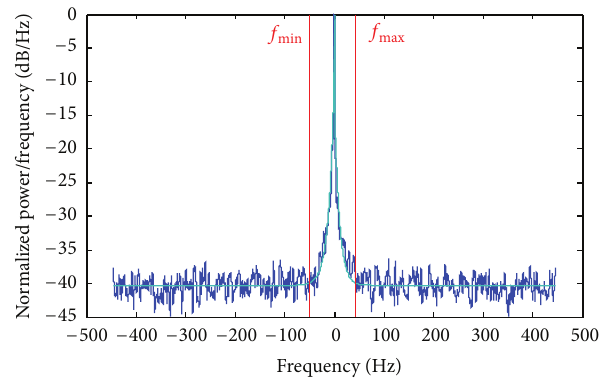
Figure 5: Frequency limits for Example